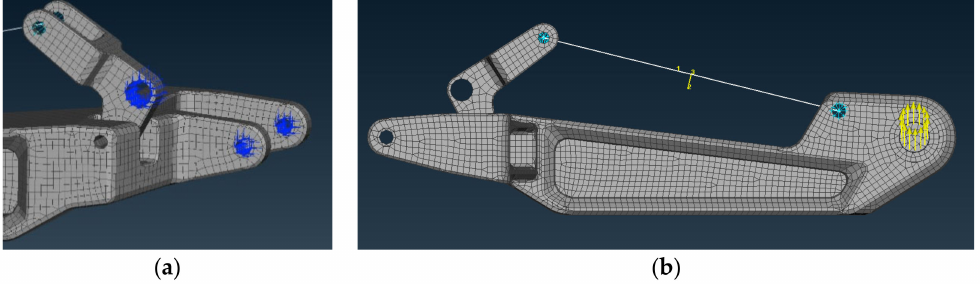
Figure 8. Finite element analysis model: ( a ) constraints; ( b )